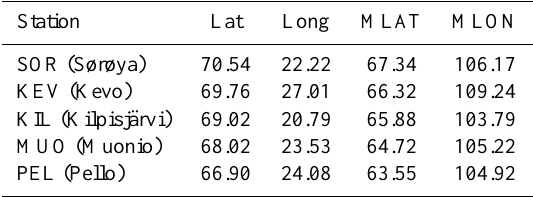
Table 1. IMAGE magnetometer stations used in this study, and their geographic and corrected geomagnetic coordinates (CGM, year